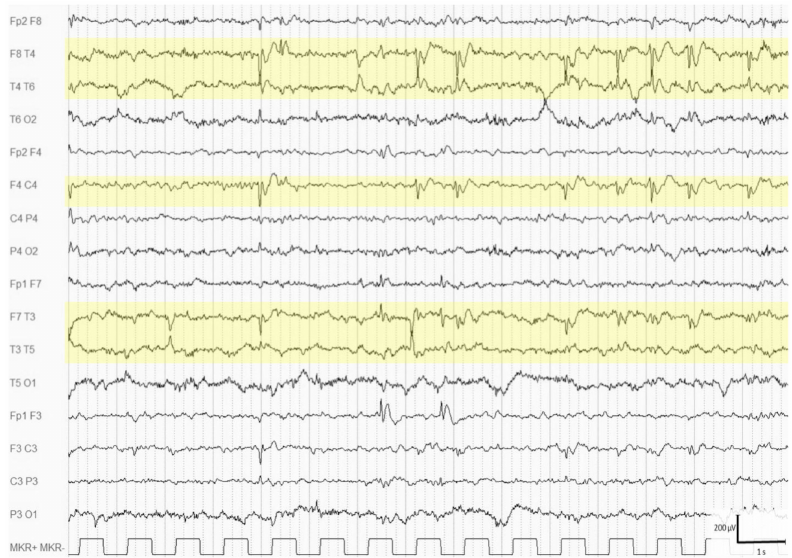
Figure 1. Wakefulness EEG of a 4-year-old boy showing numerous multifocal spikes, more prominent over the right central-temporal and the left frontal-temporal regions (highlighted areas).